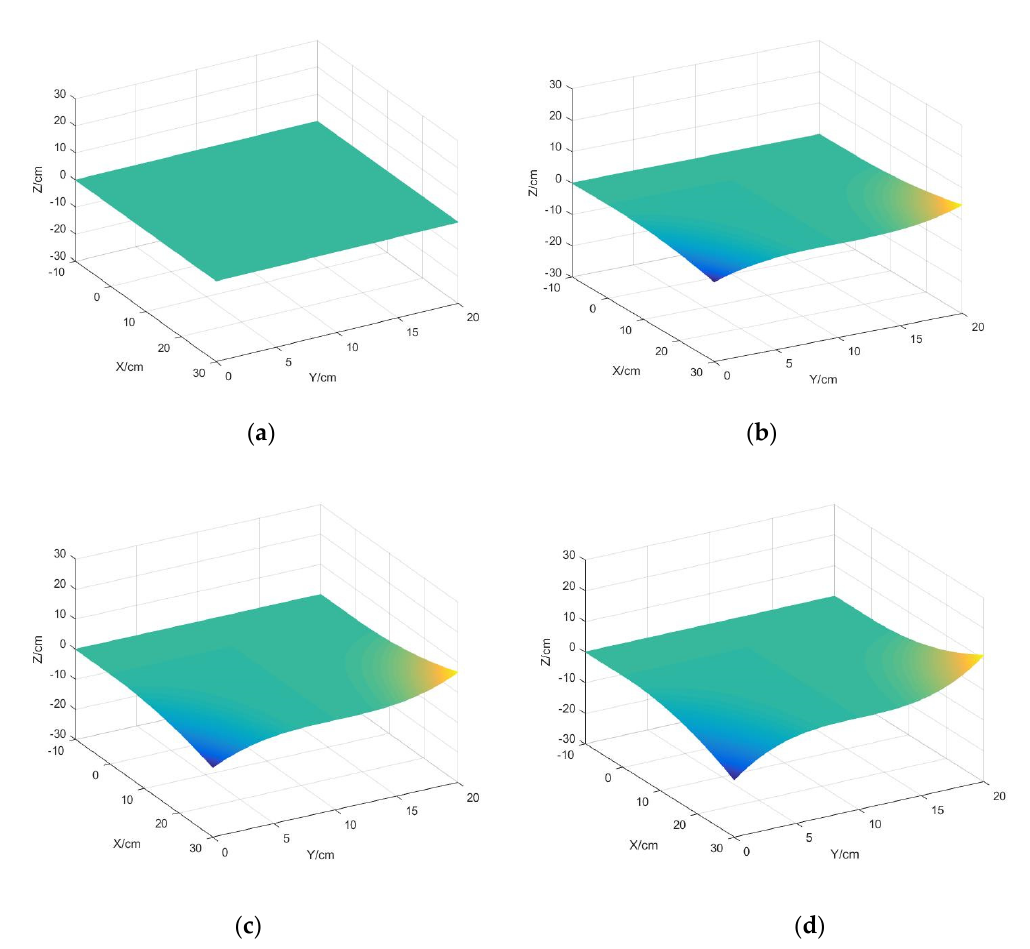
Figure 21. Test piece shape reconstruction loaded in the middle point: ( a ) Initial state, ( b ) state I, ( c ) state II, ( d ) state III.